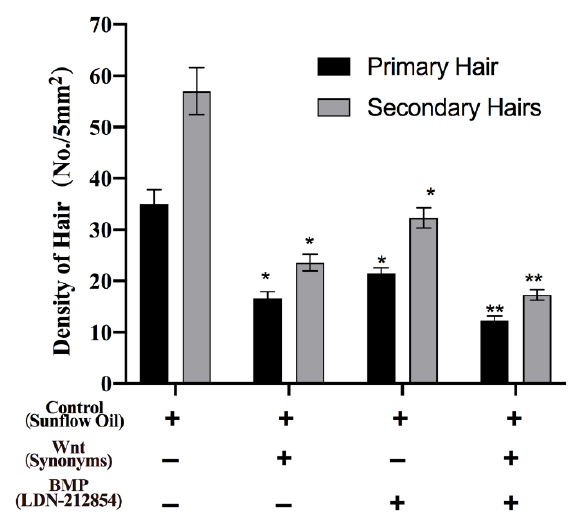
Figure 5. The hair follicle growth under the antagonist of Wnt and BMP were analyzed with the phenotype of hair growth, and both primary hairs and secondary hairs were calculated in the hair follicle stem cells with the pathways for Min pigs. The phenotype of the secondary hairs of Min pigs under stereomicroscope and the number of primary hairs and secondary hairs were analyzed for each breed in 5 mm 2 . Bars represent the standard and error. ** p < 0.01, * p < 0.05.